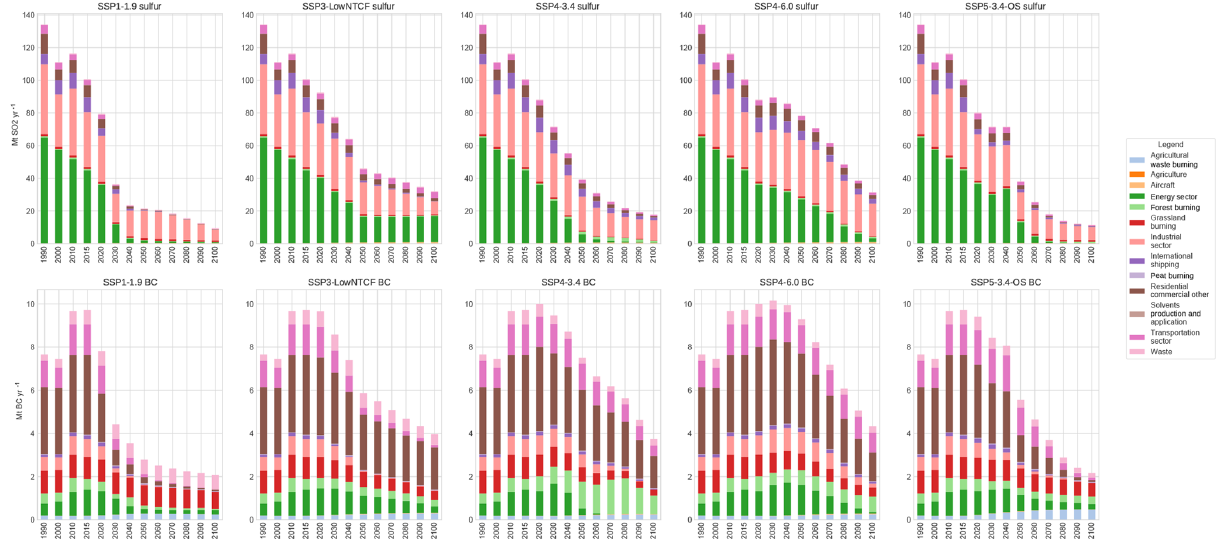
Figure E4. Sectoral breakdown for sulfur and BC emissions per year for all scenarios analyzed in this